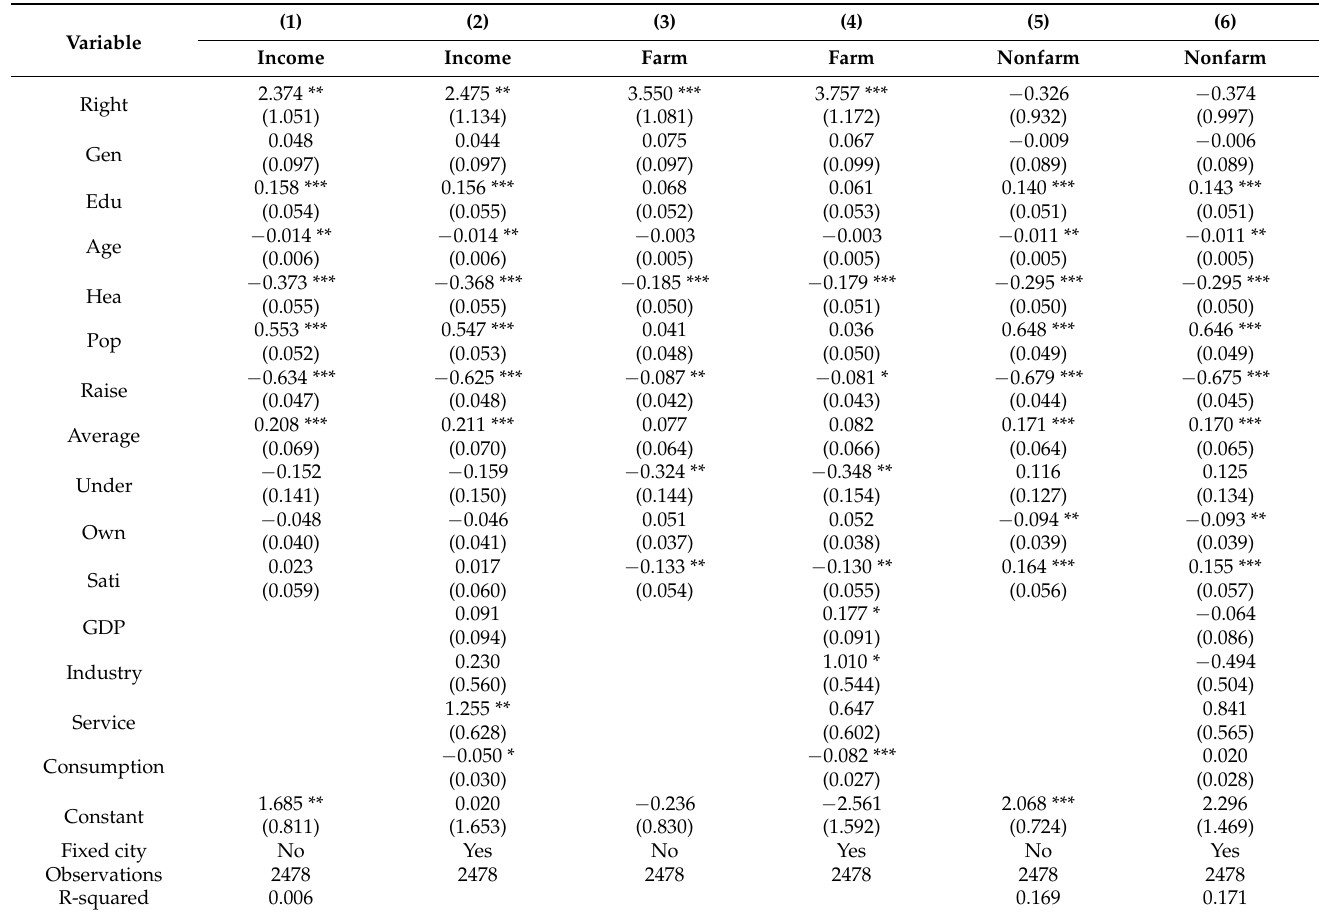
Table 6. Endogenous test of rural land right on farmers’